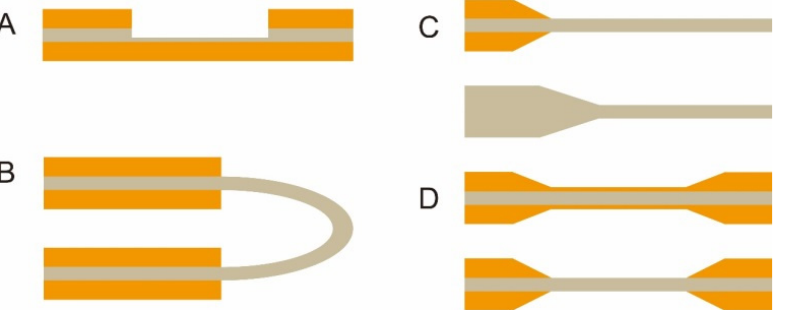
Figure 4. The most common optical fiber structures. ( A ) D-shaped fibers; ( B ) U-shaped fibers; ( C ) tapered fibers; ( D ) biconical fibers. The gray part is the core, and the orange part is the cladding. The section without the cladding is the sensing region, where the surface modification is typically performed prior to the sensing.